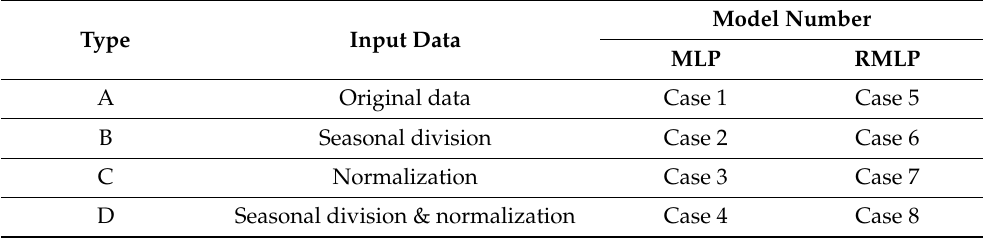
Table 3. Model number according to data